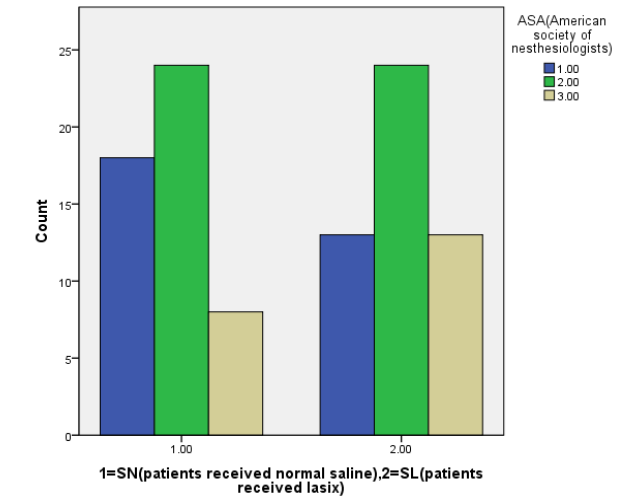
Figure(5): shocked patients received 2 ml normal saline versus shocked patients received 2 ml Furosemide in terms of ASA, there is no significant statistical difference (p=0.165).